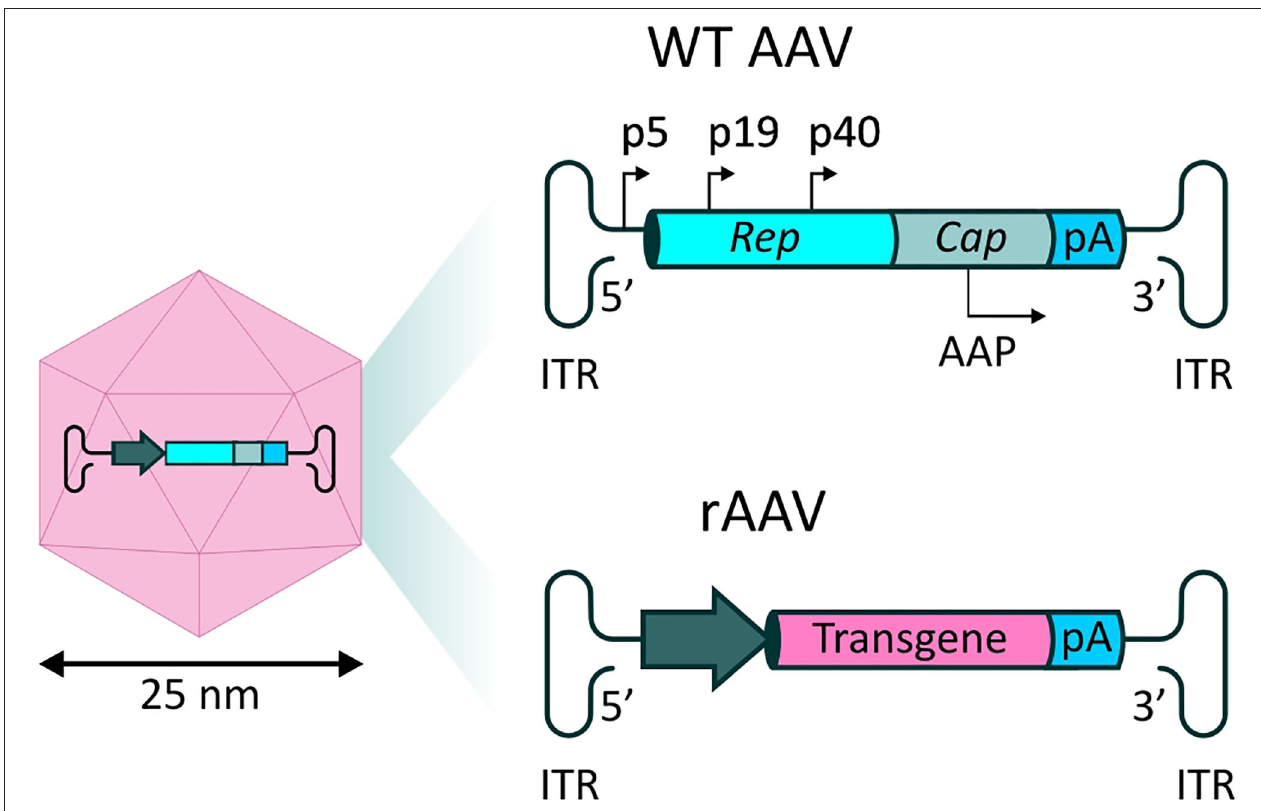
FIGURE 3 | rAAV vectors for systemic delivery of mAbs. (Left) AAV capsid structure. The AAV capsid is composed of 60 protein monomers (VP1, VP2, and VP3 subunits with a stoichiometry of 1:1:10) arranged in icosahedral symmetry. (Top right) Representation of the single stranded (ss) DNA genome found in naturally occurring AAVs. Two open reading frames (ORFs) express genes necessary for replication ( rep ) and capsid structure ( cap ). An alternate reading frame overlapping the cap gene encodes the assembly-activating protein (AAP), promoting capsid formation and stability. (Bottom right) In recombinant AAV-based vectors (rAAV), the viral genes are substituted by a synthetic transgene cassette, in which a promoter drives expression of a transgene of interest, followed by a polyA